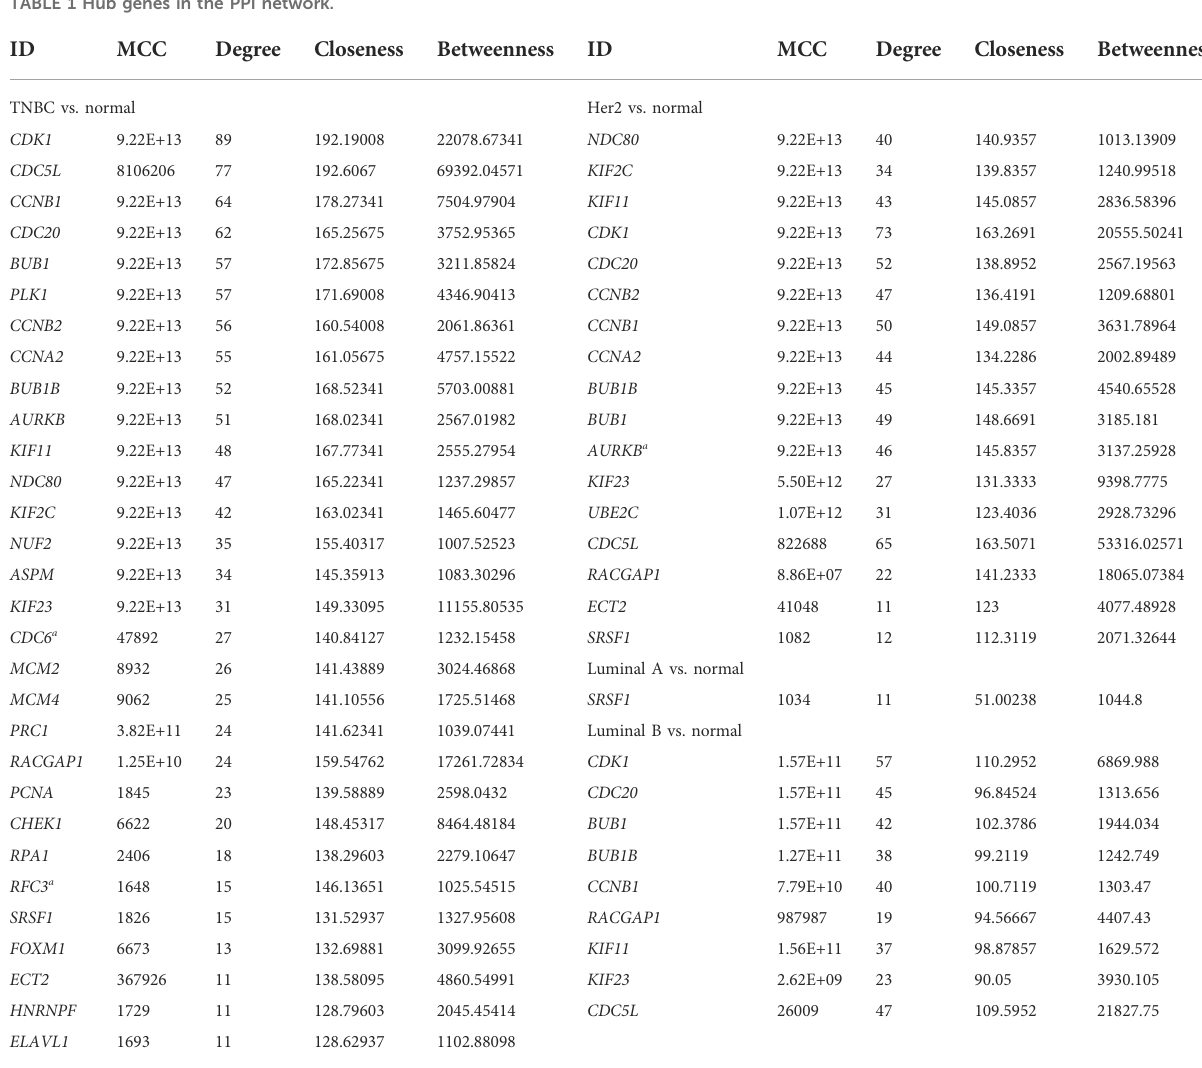
TABLE 1 Hub genes in the PPI